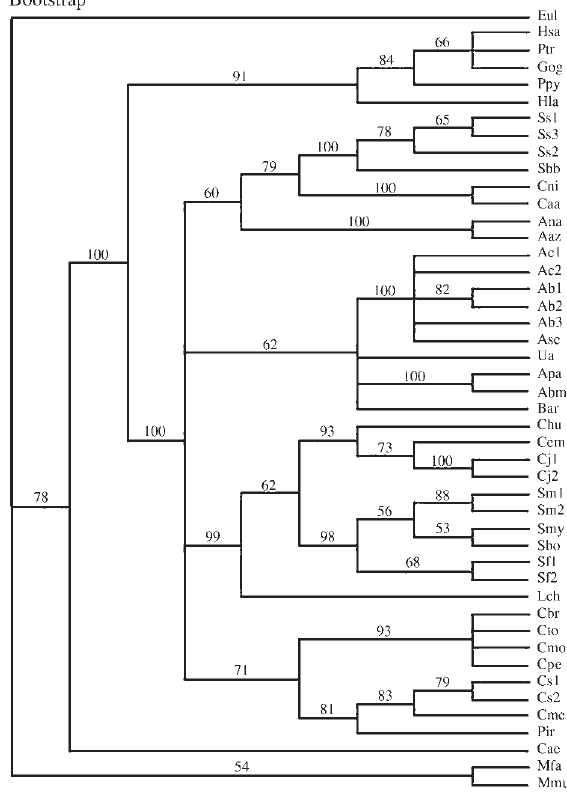
Figure 3 - Maximum parsimony tree (L = 396) obtained for the H gene of 45 primate samples. The numbers above each node are the bootstrap val- ues for 2000 replications. See text and Table 1 for the identification of the